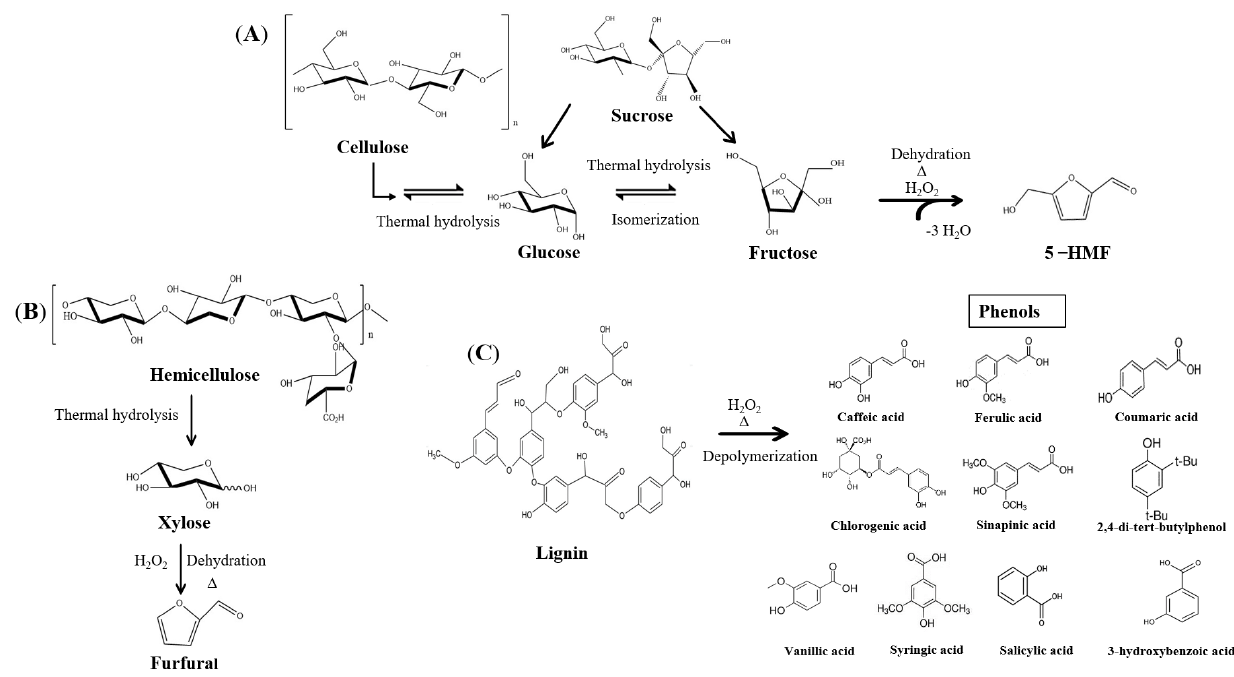
Figure 2. Expected reaction formulas of ( A ) thermal hydrolysis of cellulose and sucrose in the formation of 5-HMF, ( B ) thermal hydrolysis of hemicellulose in the formation of furfural, and ( C ) depolymerization of lignin in the production of phenols, using H 2 O 2 as a catalyst. The treatments at 130 °C showed highly significant differences, indicating that time and temperature interfere with the increase of 5-HMF (Table 1). Jeong [28] obtained 5-HMF from the green microalgae Chlorella sp. using the thermal treatment and ferric sulfate as a catalyst. This treatment increased 37.2% of 5-HMF at 170 °C for 60 min. The original vinasse had an initial concentration of furfural of 0.08 mg/L. At low tem- peratures (110 °C) and short time (20 and 30 min), furfural concentration was not detected. In contrast, at 120 and 130 °C and 30 or 40 min, the furfural concentration significantly increased up to 38-fold with 3.07 mg/L (T130:40m:0.5P) compared to OV (Table 1). Rodríguez-Félix et al. [13] reported 52.11 mg/L of furfural in tequila vinasses. It is possible to find hemicellulose in the OV derivate of the mill agave process. It could be transformed to xylose and after furfural by dehydration at high temperatures [16] (Figure 2B). Wang et al. [29] reported a yield of 76.6% of furfural from commercial xylose and using mesoporous carbon derived from sulfonated lignin, initiating the 100% conversion of xylose to hydrolysis at 200 °C for 45 min. The treatments at 120 and 130 °C had the highest recovery of furans (5-HMF and furfural). Nevertheless, the interaction of three factors (temperature, time, and catalyst) is necessary to promote an increase in the concentration of these compounds (Table 2). The use of green catalysts arises as an alternative for substituting homogeneous cat- alysts such as organic acids, mineral acids, metal chlorides, metal triflates, and ionic liq- uids, or heterogenic catalysts such as resins, acidic zeolites, metal oxides, acidulated metal oxides, metal phosphates, silicas and clays functionalized, carbonaceous acids, and mag- netic materials [30]. Sweygers et al. [31] obtained 5-HMF and furfural using HCl as a cat- alyst and microwave-assisted in bamboo ( Phyllostachys nigra “Boryana”), they had a yield of 21% 5-HMF and 13% of furfural. However, different authors report that homogeneous catalysts such as HCl and H 2 SO 4 are used most frequently as they are efficient and low cost. However, drawbacks of these catalysts include the highest corrosion in waste gener- ation and separation problems [32].